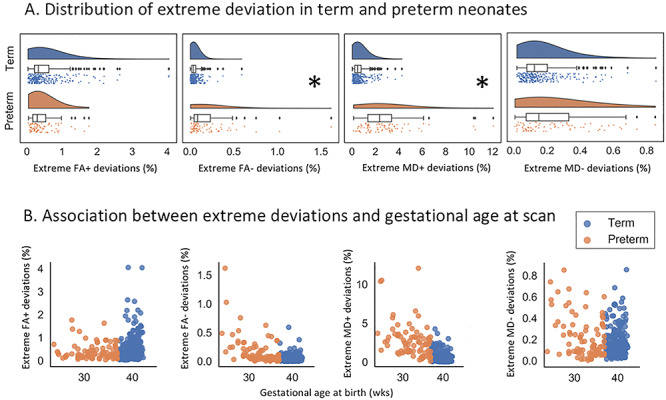
Association between prematurity and proportion of extreme deviations, captured by the atypicality index. (A) Preterm infants had higher FA− and MD+ atypicality indices compared with term-born infants (highlighted by a star). There was no difference between the two samples in the proportion FA+ and MD−. (B) Associations between the atypicality index and GA at birth in term and preterm infants. In the preterm sample, there was a negative association between GA at birth and FA− and between GA at birth and MD+ deviations. Note that the y-axis in B is not fixed.